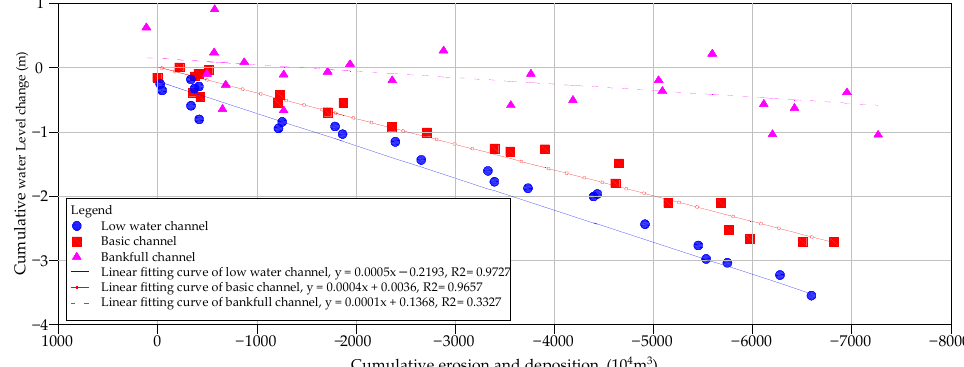
Figure 11. Relationship between cumulative erosion and deposition and cumulative water level change.